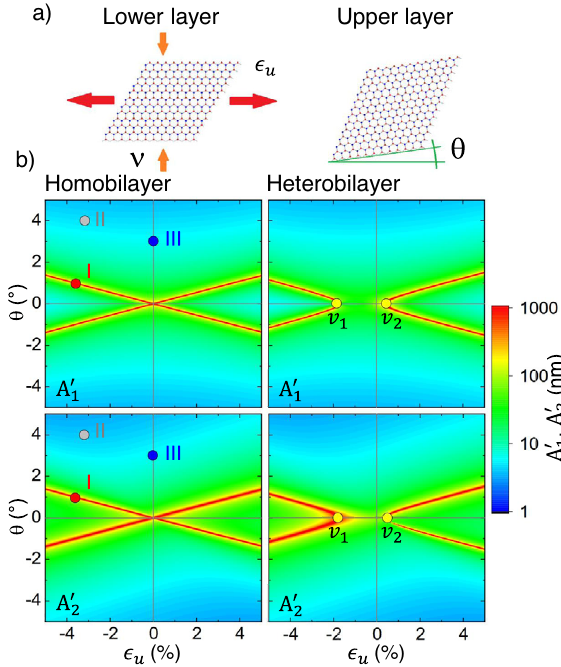
1 Fig. 3 Deformation of the moiré lattice parameters in hexagonal bilayers under uniaxial heterostrain. a Schematic of moiré lattice formation under uniaxial heterostrain ϵ u . The deformation of the lower layer due to strain along a zigzag direction and Poisson ratio ν are depicted by the arrows. The upper layer was stacked with an angle θ respect to the lower layer. b Moiré lattice parameters A 0 1 (upper panels) and A 0 (lower panels) for the homobilayer- and 2 heterobilayer structures (left and right panels, respectively) as a function of uniaxial strain and stacking angle. Spots labeled as I, II, and III correspond to the different moiré lattices presented in real space in Fig. 4b and those marked as v 1 and v 2 identify the vertexes of the divergence curves in the heterobilayer case.